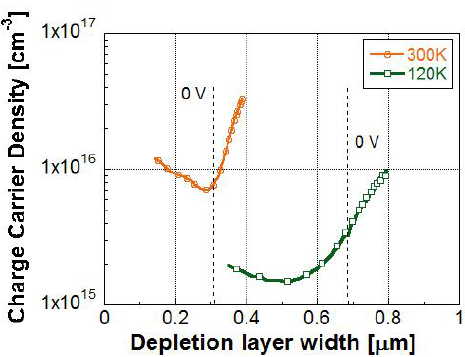
Figure 5. Capacitance-voltage profiles obtained at 300 K and 120 K on typical CIGS solar cell with intermediate NaF buffer-layer. The test signal frequency is 1 MHz.